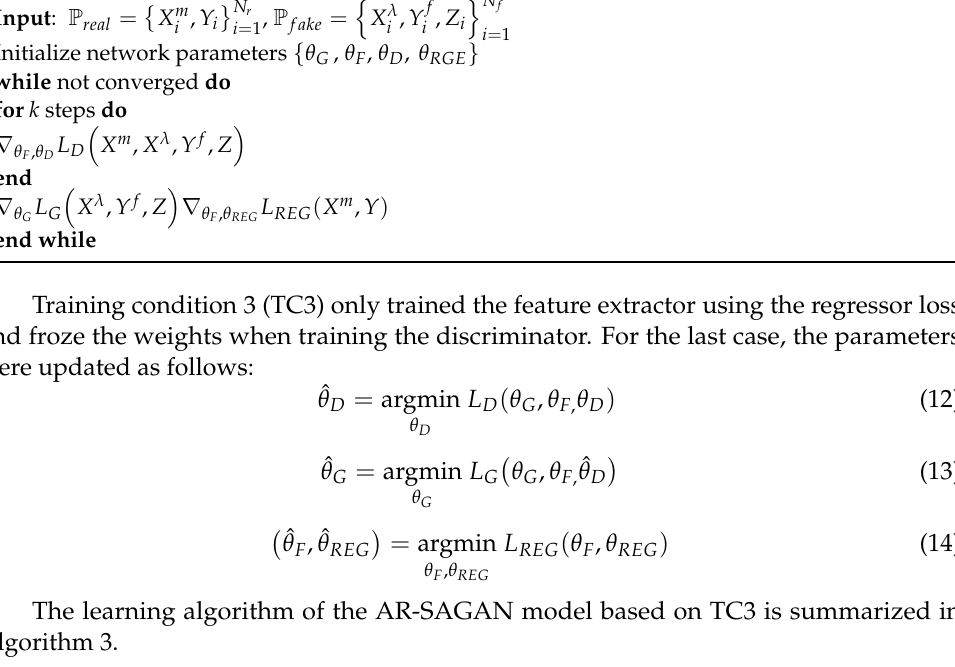
Algorithm 2 : Training AR-SAGAN based on